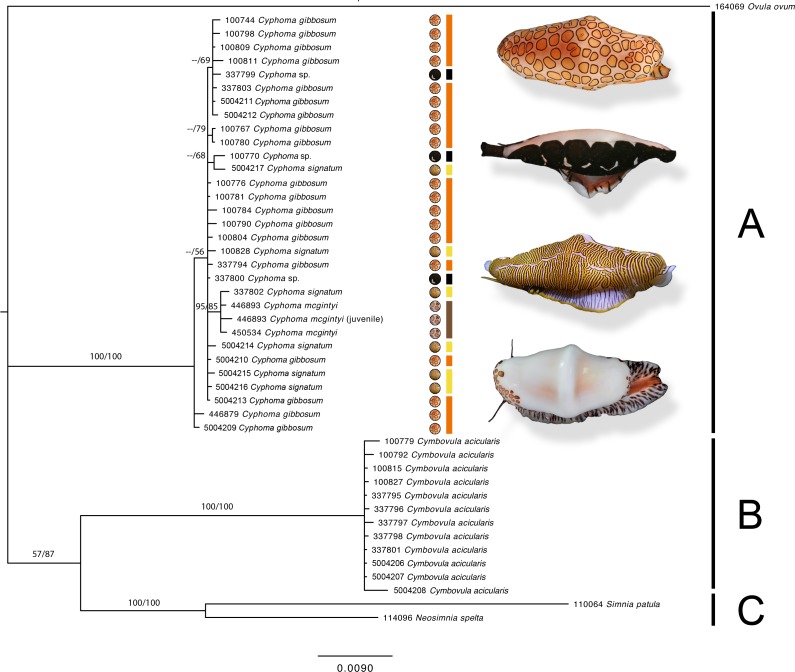
Phylogram based on the concatenated dataset of four markers.The support values in this Bayesian consensus tree are noted as Bayesian inference/Maximum likelihood. Clades A, B, and C are discussed in the results. For the Cyphoma species their respective characteristic mantle patterns are depicted per specimen including photographs of the live animals (not to scale). Bar colours: orange, C. gibbosum; yellow, C. signatum; brown, C. mcgintyi; black, Cyphoma “black morph”. Numbers preceding species names refer to the specimen codes in Table S1.